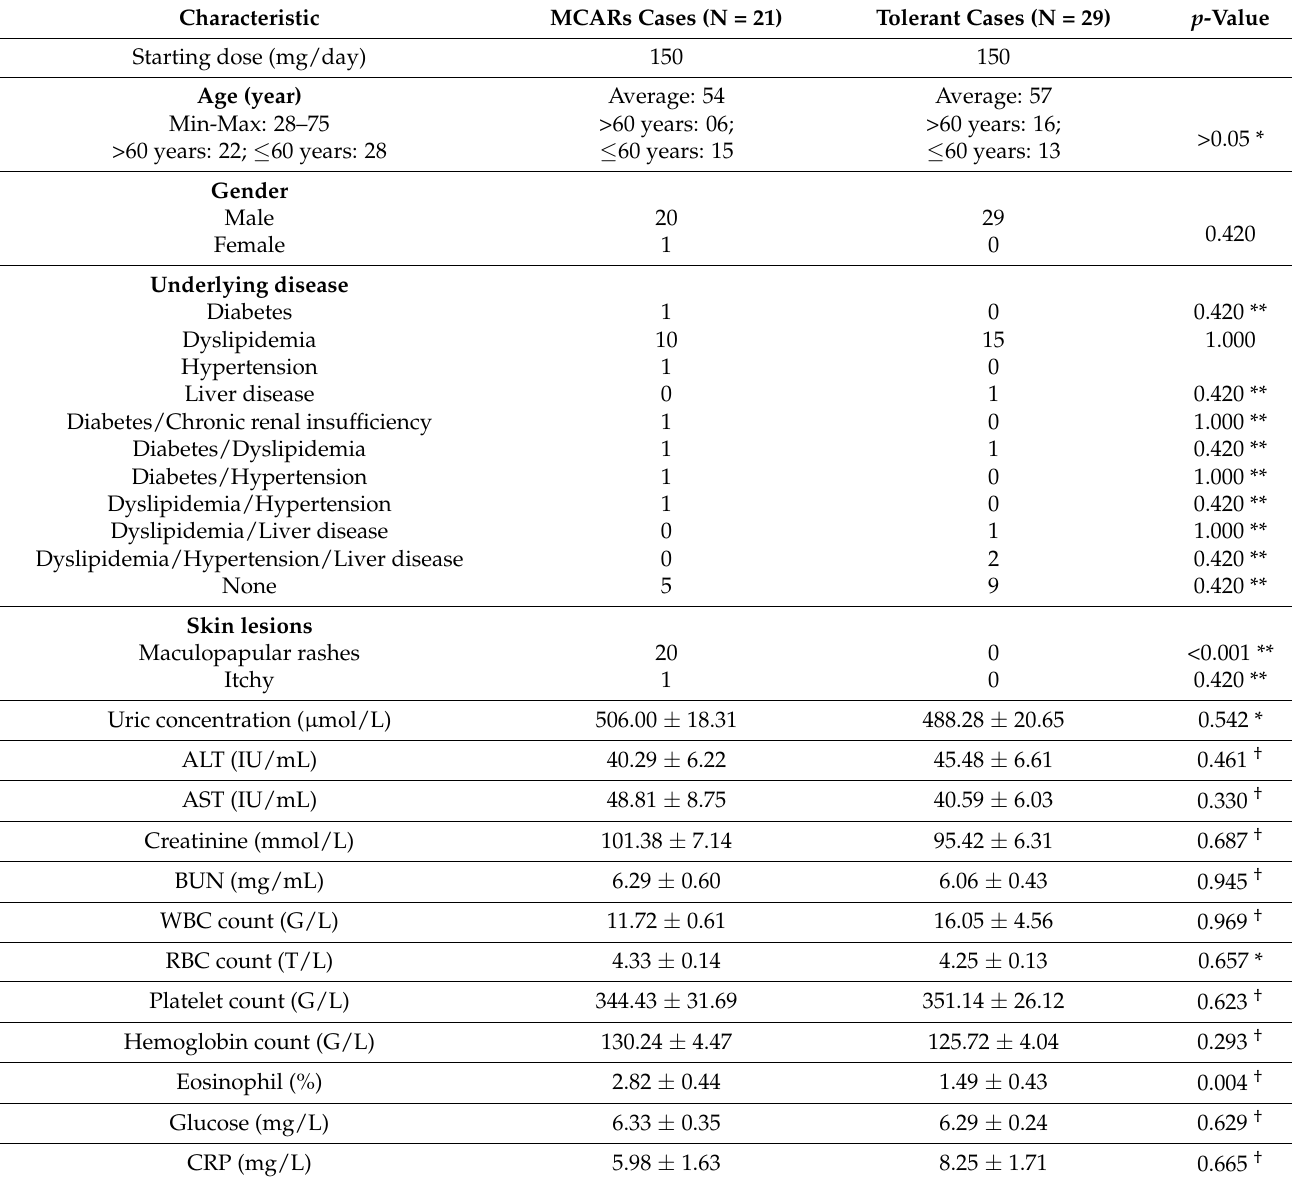
Table 1. Demographic data of the patients with gout, with and without cutaneous adverse reactions (MCARs). Characteristic MCARs Cases (N =